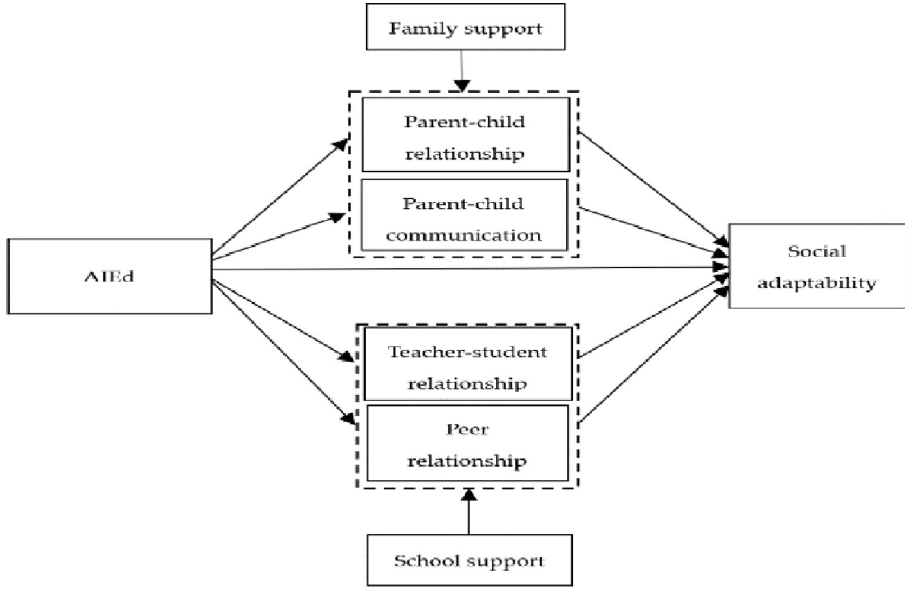
Fig 1. Model of mediatory role of social support between AIEd and social